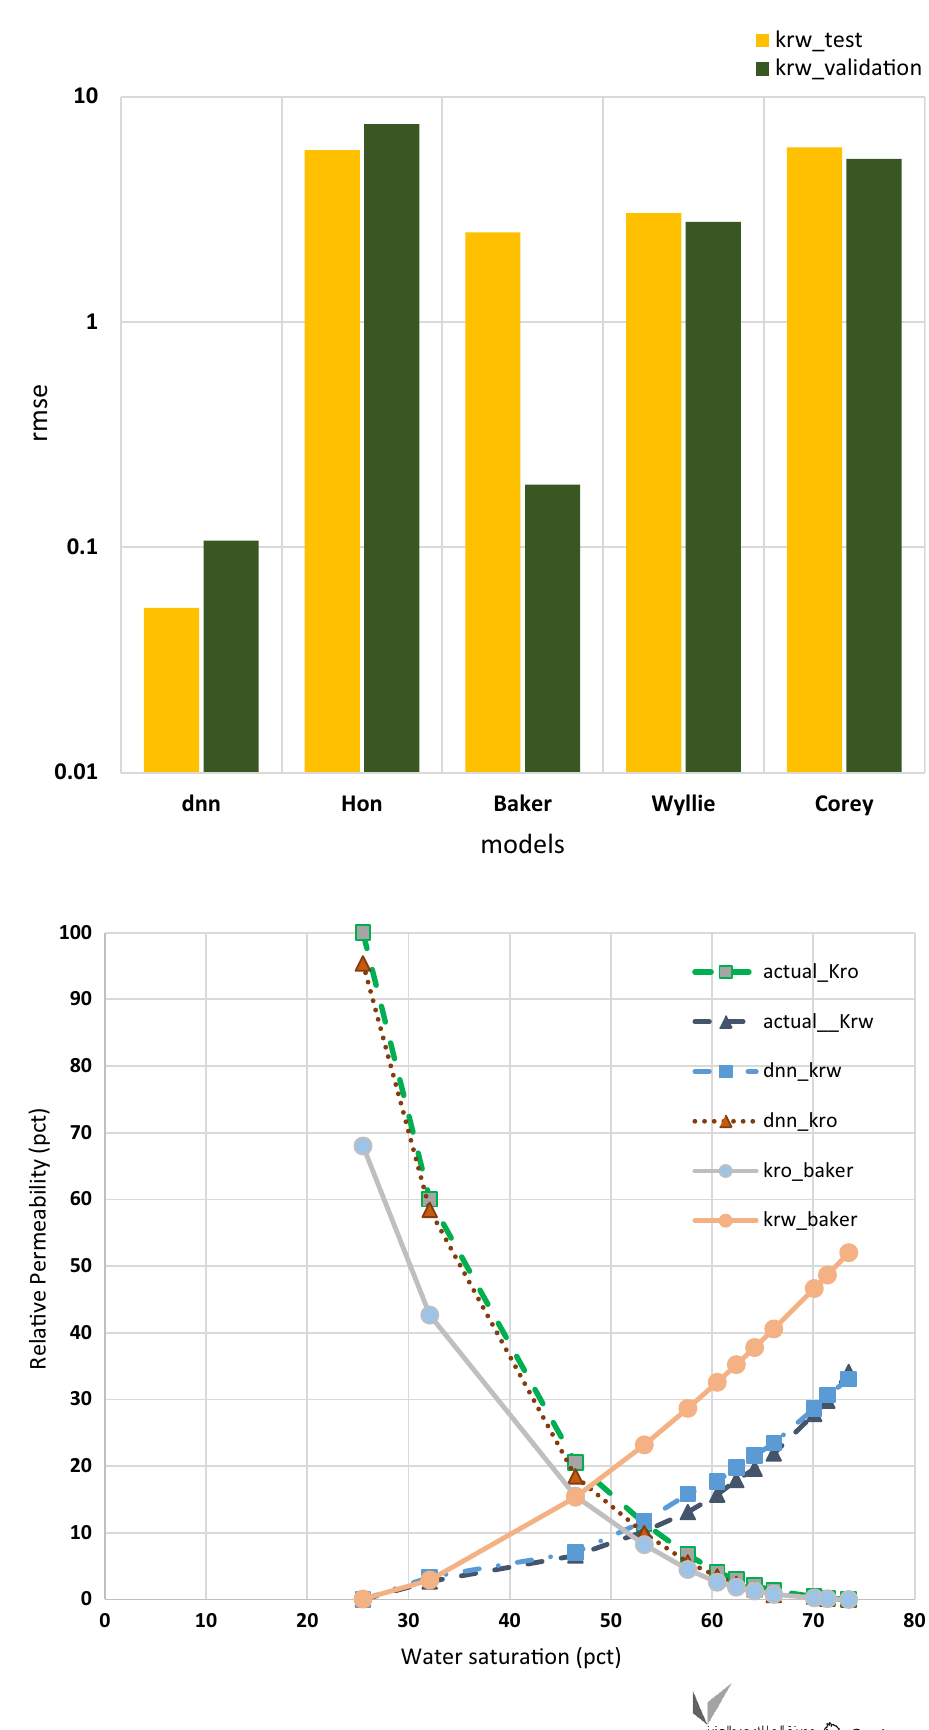
Fig. 10 Comparison of Wyllie, Corey, Baker, Honarpour, deep neural networks models for the Stratjford reservoir, NorthSea